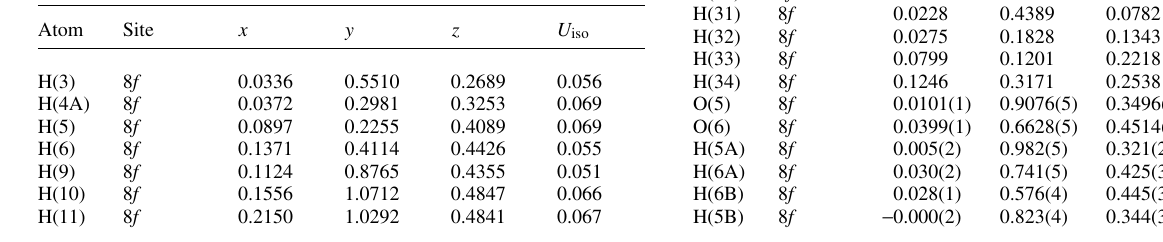
Table 2. Atomic coordinates and displacement parameters (in Å 2 ) .